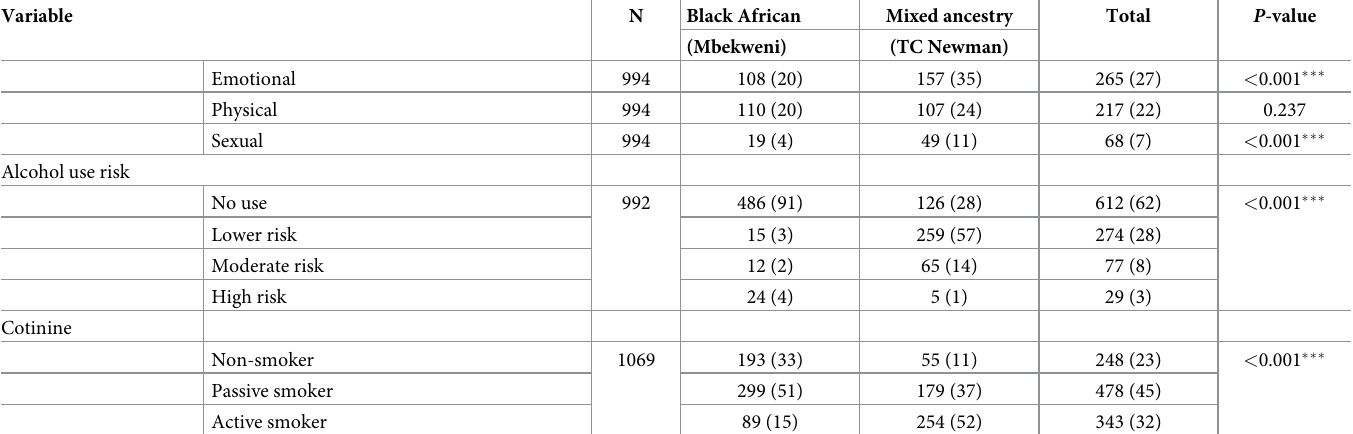
(37–40) weeks and 191 (17%) infants were born preterm. Amongst these, most were late pre- term births, with a median gestational age of 35 (32–36) weeks. Most babies were appropriate size, with a median WAZ score -0.6 SD (-1.3 to 0.1), HAZ score 0 SD (-0.9 to 0.9) and median head circumference Z-score -0.5 SD (-1.3 to 0.3). Low birth weight for gestational age ( < -2SD) occurred in 99 infants (9%). No baby had any observable gross deformity at birth. Of 244 HIV-exposed infants, only 2 (1%) were known to be HIV-infected; they tested positive postna-